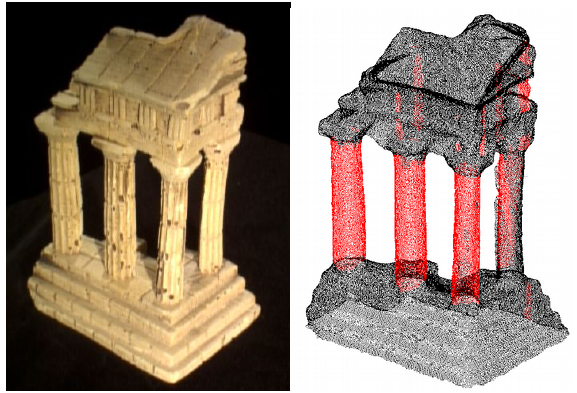
Figure 2. Temple of the Dioskouroi and preliminarily segmented 3D point clouds.